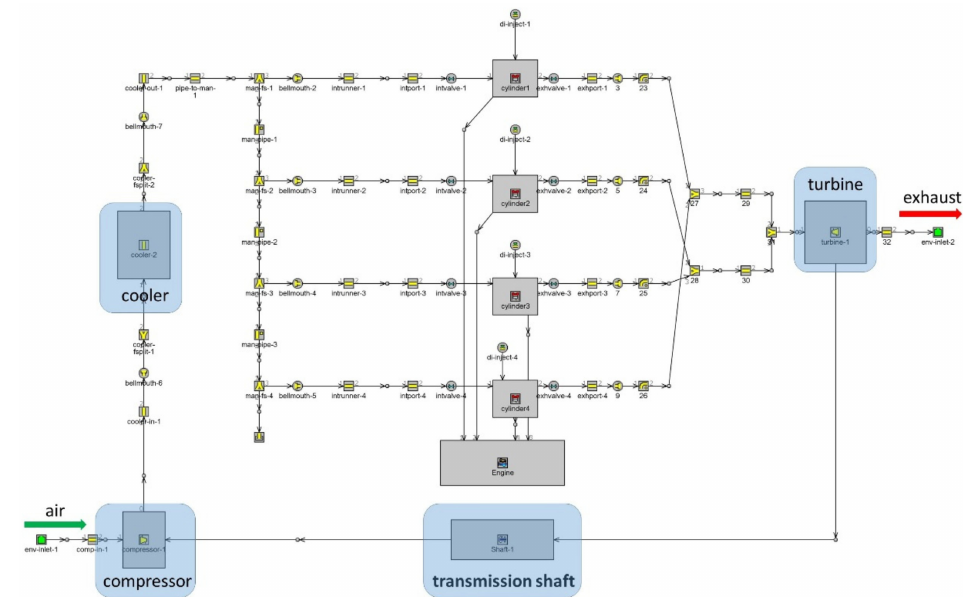
Figure 1. The internal combustion engines (ICE) model built in GT-POWER.